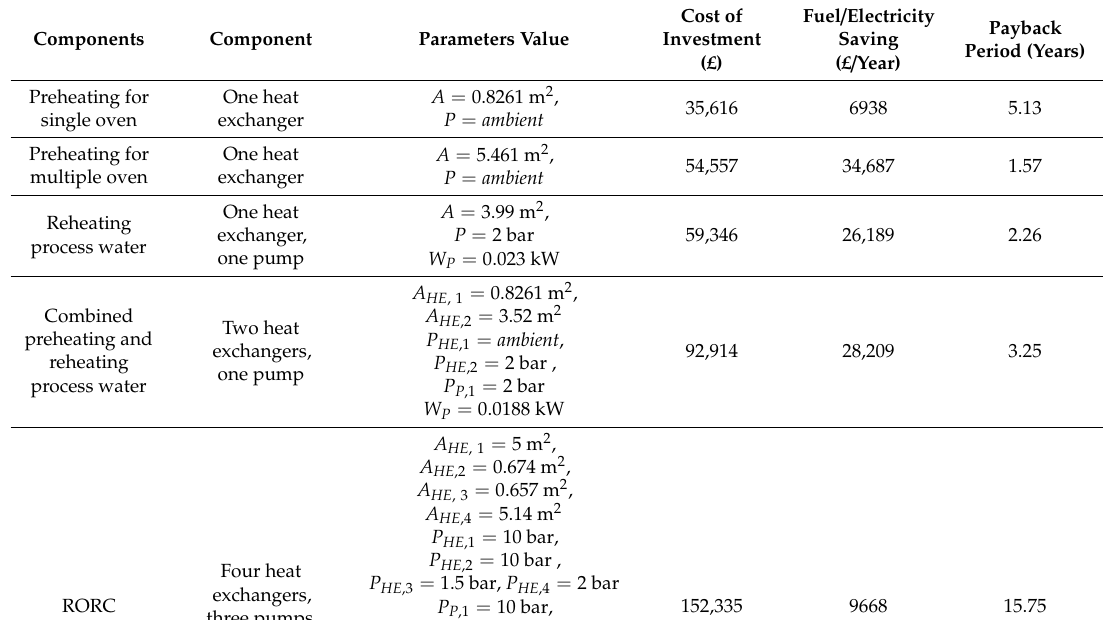
Table 16. Annual energy, operational cost and CO 2 savings for the studied heat recovery technologies based on 7000 h of operation per